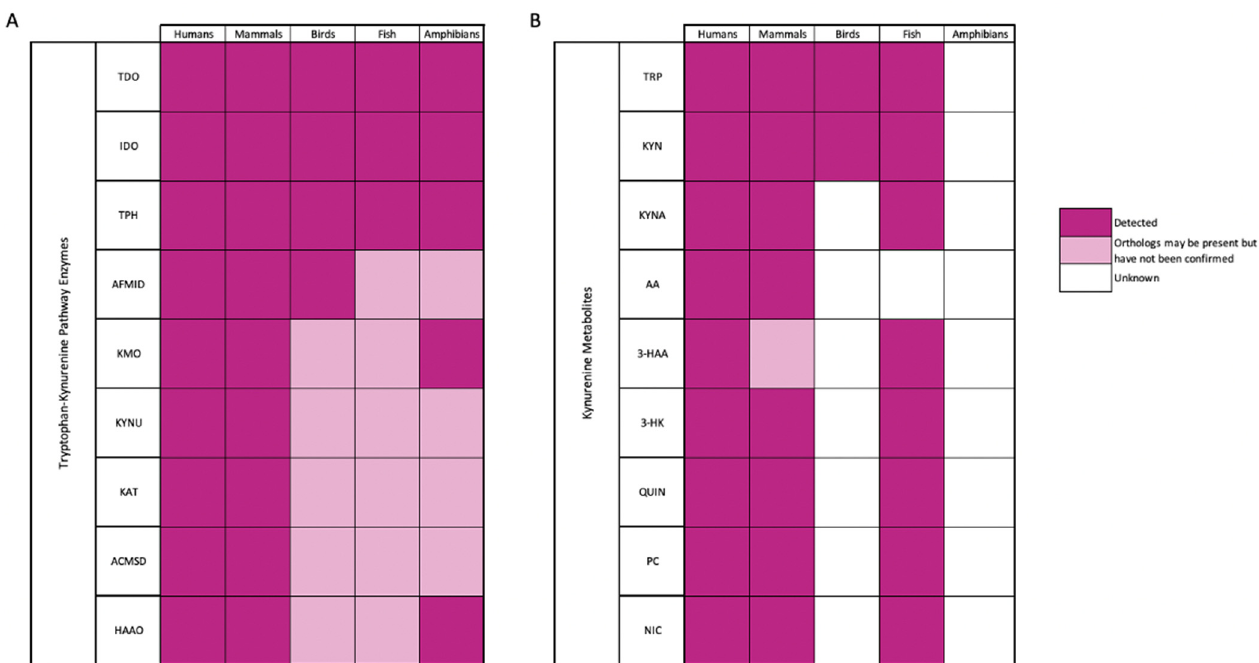
Figure 3. A review of kynurenine pathway ( A ) enzymes and ( B ) metabolites detected across animal kingdoms. If both gene and protein data was available, it was considered detected, and labelled dark pink. If enzymatic and metabolite orthologs may be present (via. computational curation of databases) but have not yet been confirmed in gene or protein levels, it was labelled light pink. If no information could be found yet, it was considered unknown and labelled white.